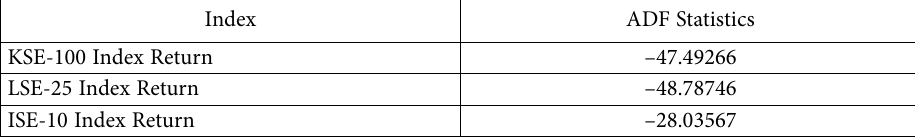
Table 2. Stationary in stock markets indices (source: authors’ estimation)